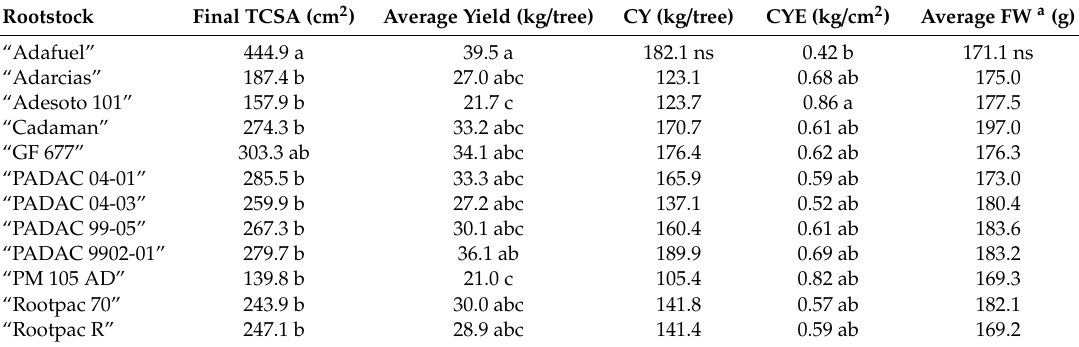
Table 5. E ff ect of rootstock on horticultural traits in the ninth year (2017) after planting.